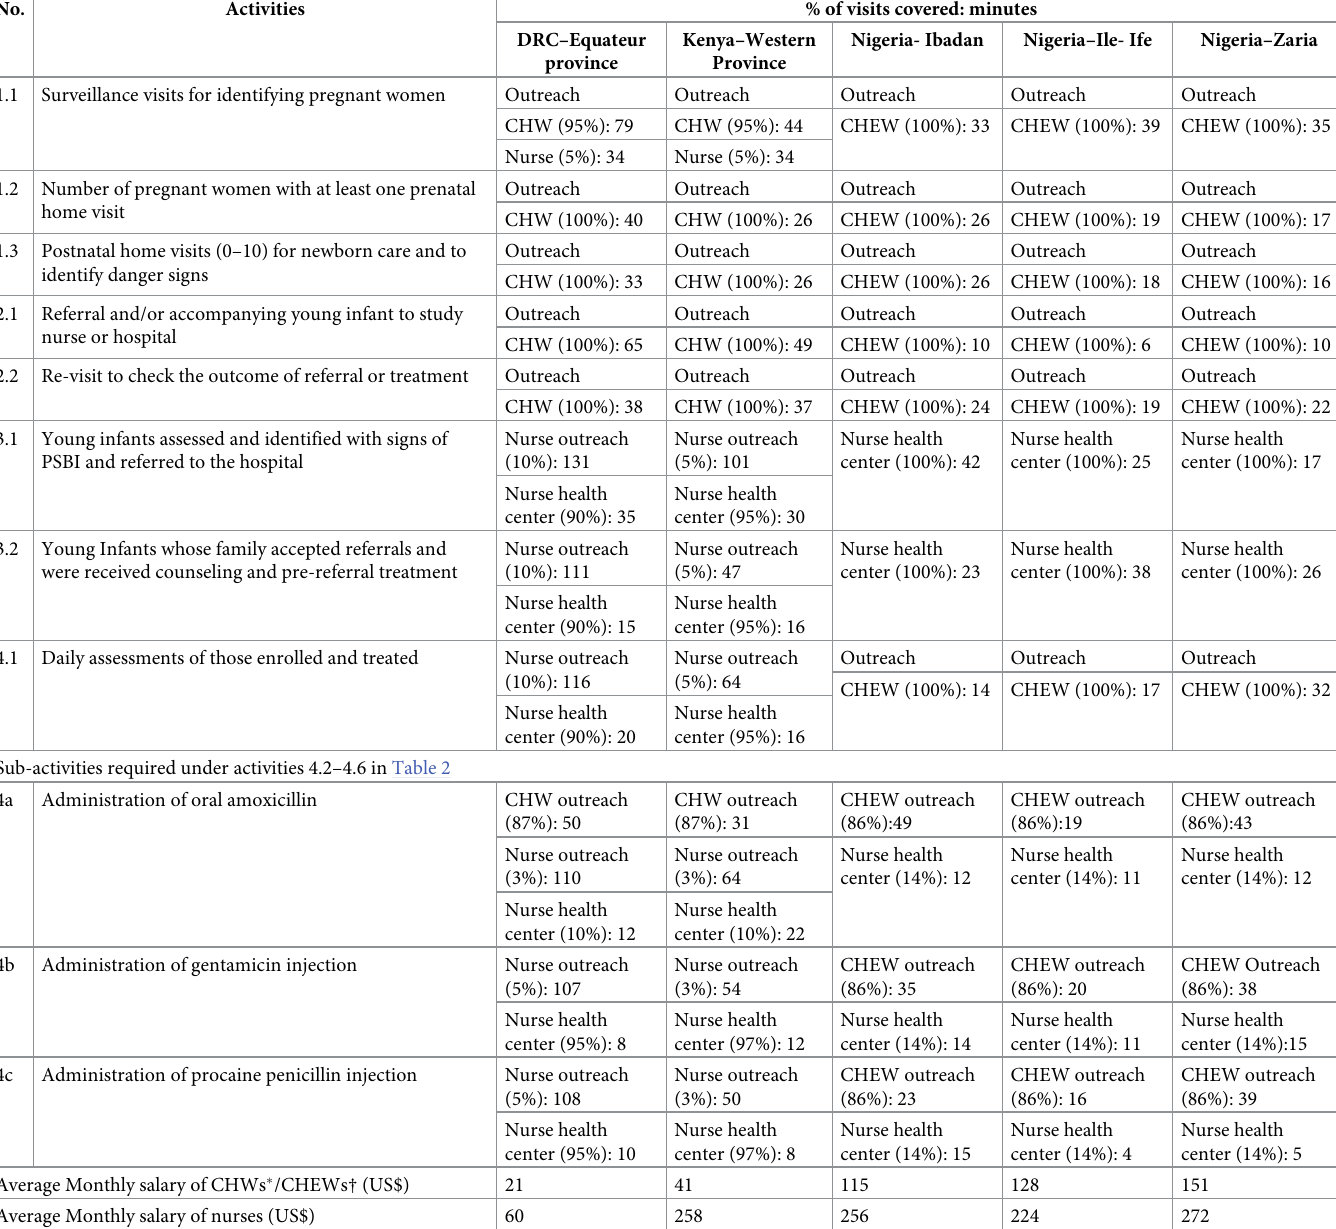
Table 3. Average time taken in minutes for each provider per visit by activity and monthly salaries of the providers at five sites in the DRC, Kenya and Nigeria, 2012.